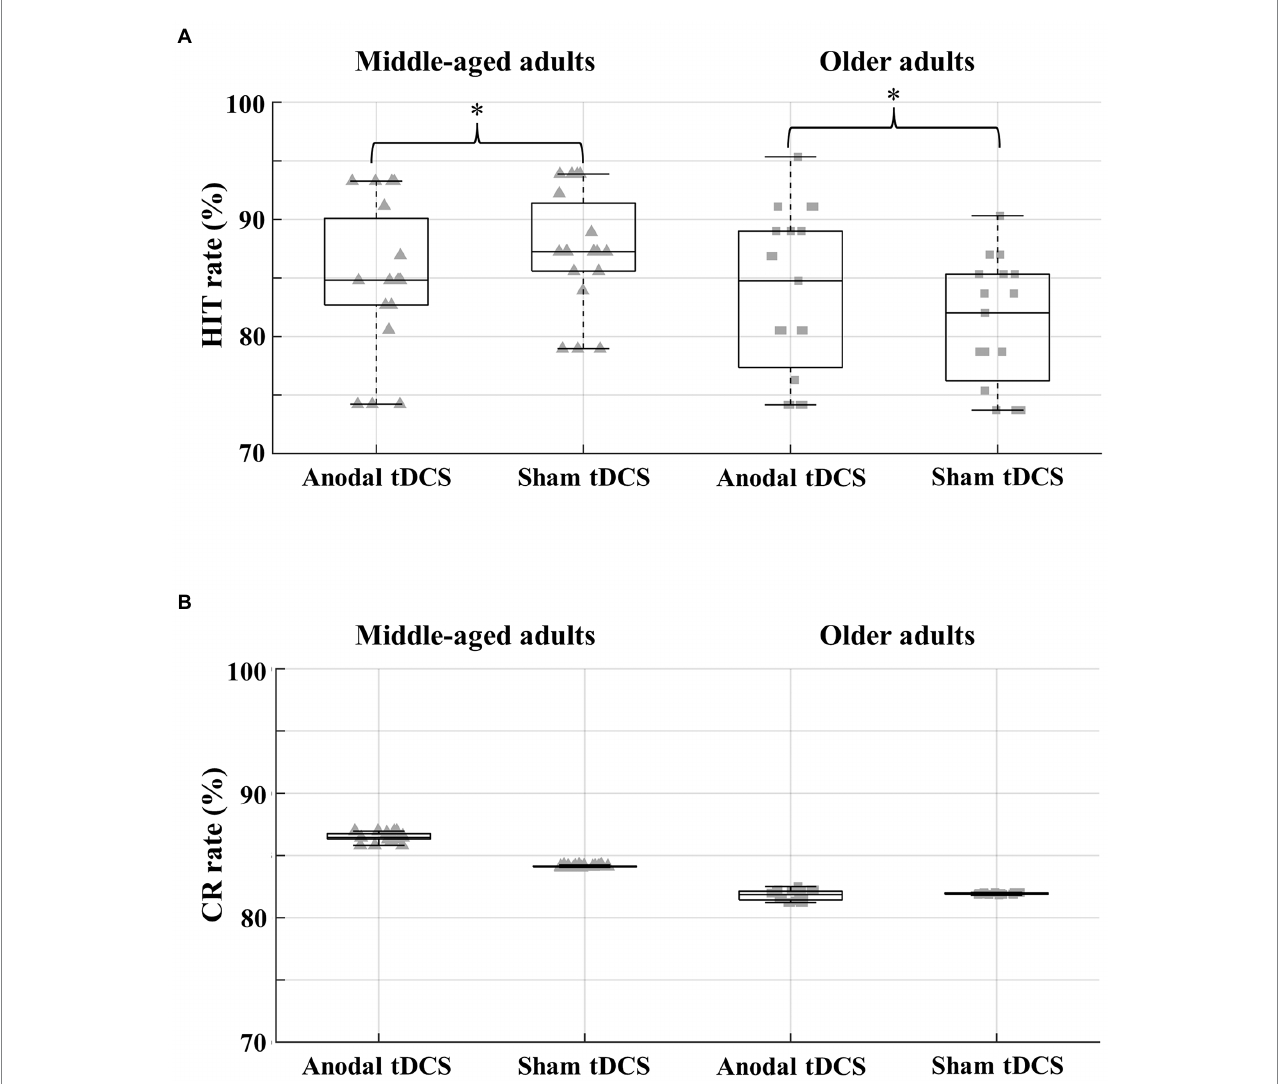
FIGURE 2 Behavioral results. (A) Boxplots depicting the hit rate obtained during the recognition EM task in middle-aged (left) and older adults (right) after anodal and sham tDCS sessions; (B) Boxplots depicting the correct rejection rate obtained during the recognition EM task in middle-aged (left) and older adults (right) after anodal and sham tDCS sessions. For each boxplot, the rectangles represent the interquartile range from the 25th percentile (quartile 1, Q1; lower black bar) to the 75th percentile (quartile 3, Q3; upper black bar), with the horizontal bar inside representing the 50th percentile (quartile 2, Q2, median), and the horizontal bars depicting the largest (upper bar) and smallest (lower bar) values within 1.5 times the interquartile range above the 75th percentile and below the 25th percentile, respectively. * indicates a significant